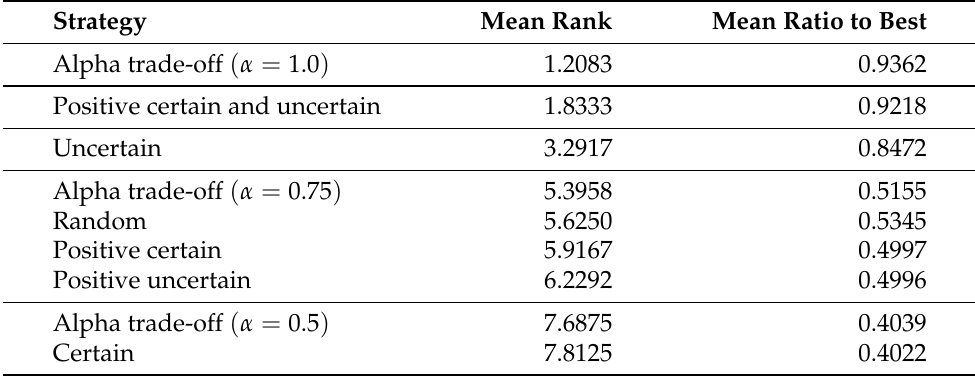
Table 11. AL strategies sorted according to mean rank of